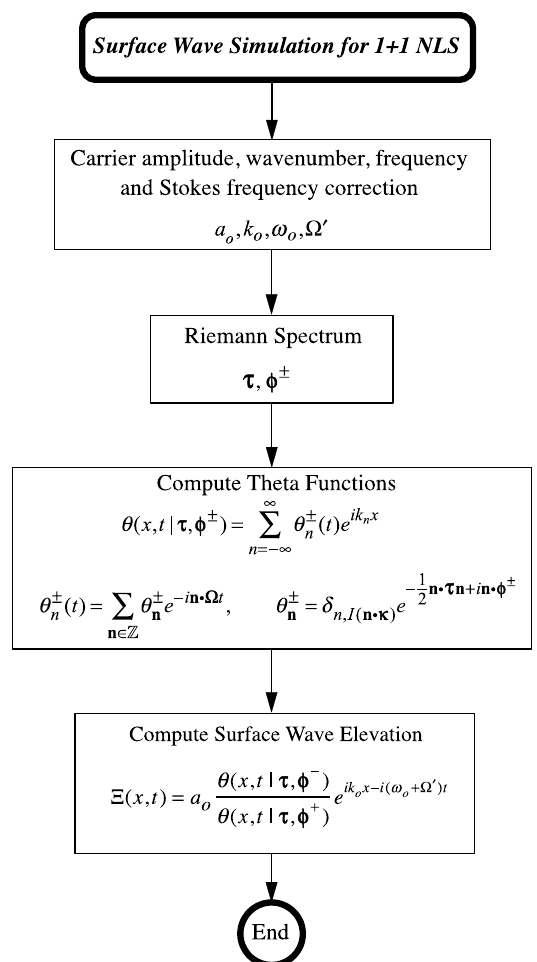
Figure 16. Two ‐ dimensional wave model based on the Riemann spectrum.